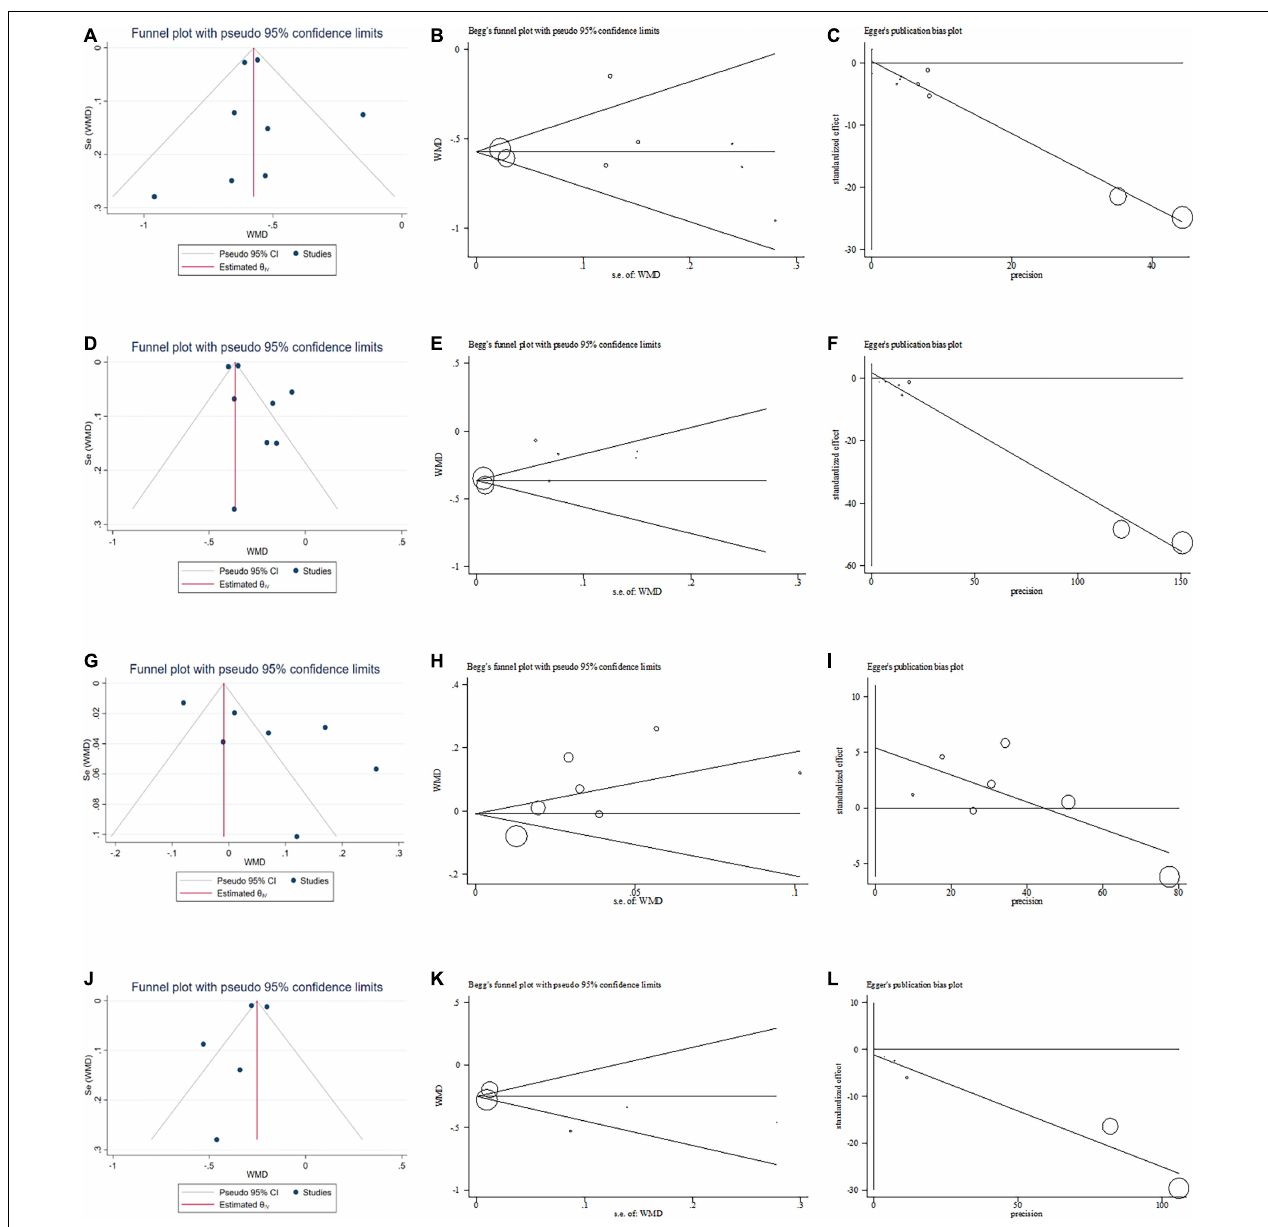
FIGURE 6 | Publication bias. (A) Funnel plot for total cholesterol (TC). (B) Begg test for TC. (C) Egger test for TC. (D) Funnel plot for triglyceride (TG). (E) Begg test for TG. (F) Egger test for TG. (G) Funnel plot for high-density lipoprotein cholesterol (HDL-C). (H) Begg test for HDL-C. (I) Egger test for HDL-C. (J) Funnel plot for low-density lipoprotein cholesterol (LDL-C). (K) Begg test for LDL-C. (L) Egger test for LDL-C. WMD, weighted mean